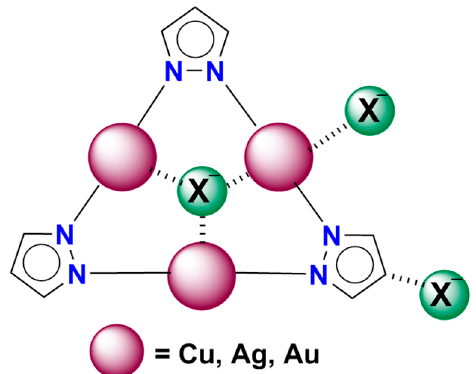
Figure 2. Schematic view of the possible complexes with X − (X = F, Cl and Br). The scheme shows the possible interaction sites.